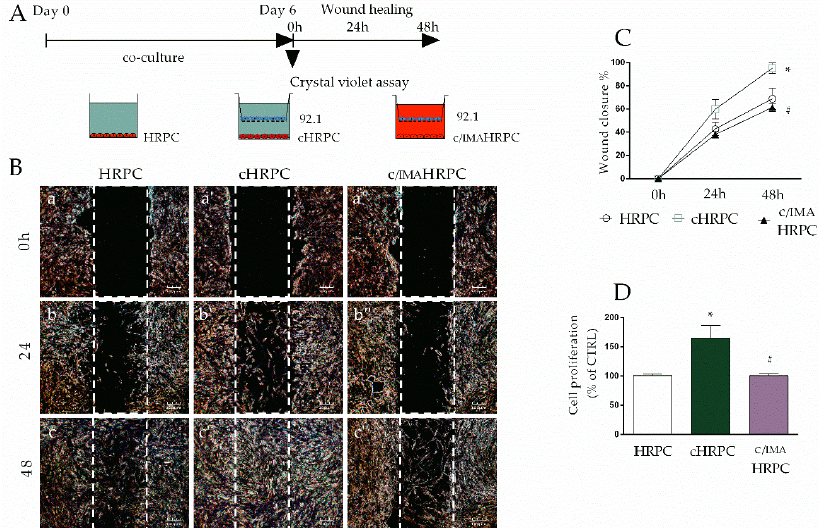
Figure 2. Imatinib reduces the increased cell migration and proliferation in human retinal pericytes (HRPC) induced by 92.1UM. Cell migration and proliferation were evaluated in HRPC cultured alone (control, HRPC) or in the presence of 92.1 without (cHRPC) or with 5 μ M of imatinib (c/IMAHRPC) for 6 days. ( A ): schematic representation of performed experimental model. ( B ): wound healing assays with representative images of control HRPC, cHRPC, and c/IMAHRPC immediately after the scratch at 0 h ( a , a’ and a” , respectively), after 24 h ( b , b’, and b” , respectively), and after 48 h of incubation ( c , c’, and c” , respectively). Percentage of wound closure was quantified by Image J software ( C ). Crystal violet assays were carried out in coculture after 6 days of conditioning. ( D ). All data represent mean ± SEM obtained from at least three independent experiments * p < 0.05 vs. control